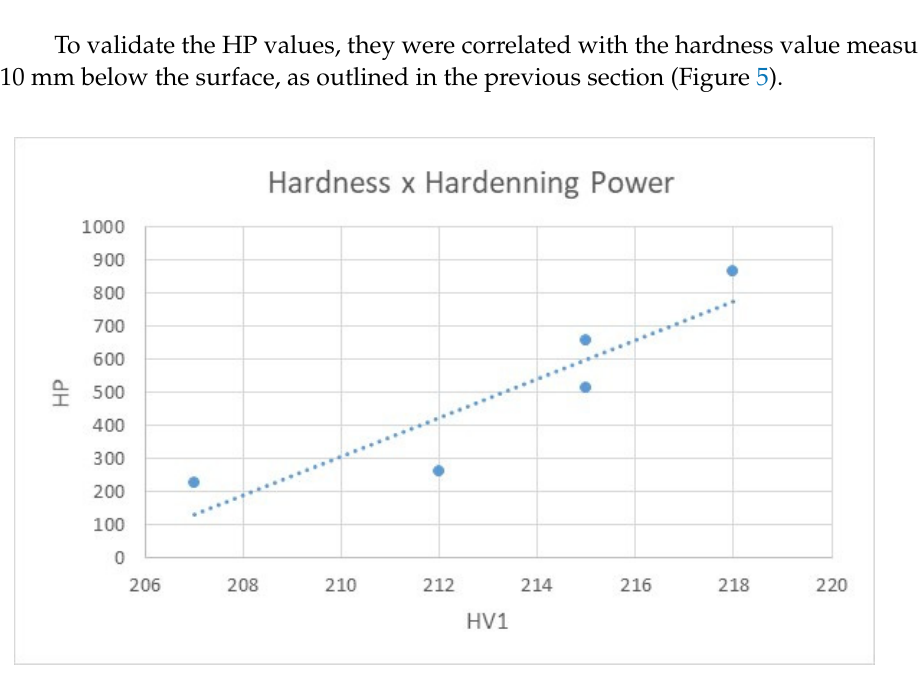
Figure 5. Correlation between hardness and Hardening power.